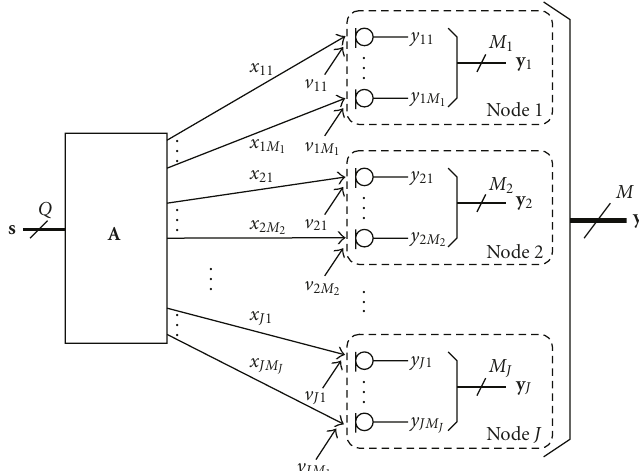
Figure 1: Data model for a sensor network with J sensor nodes, in which node k collects M k noisy observations of the Q source signals in s